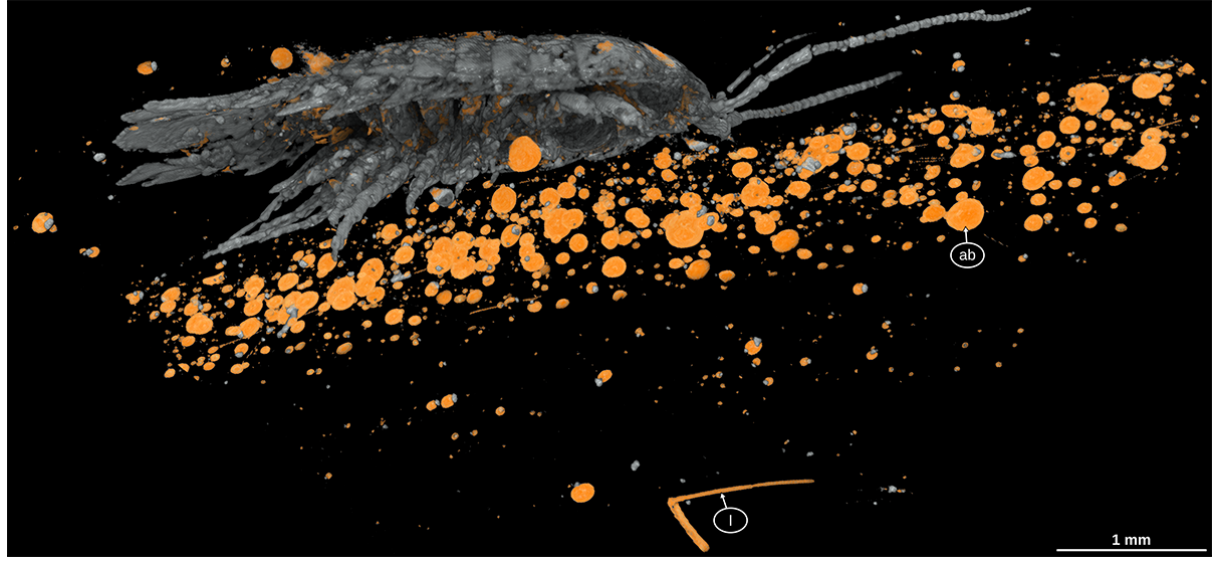
Figure 9. Holotype of Electrolana madelineae sp. nov. (NHMW 2017/0052/0001), habitus in ventrolateral view and surrounding objects in the resin, volume rendering image, two different transfer functions and clipping planes applied, orange colour transfer function solely depicts extremely low-x-ray contrast areas (gas phase). ab, air bubble; l, leg,